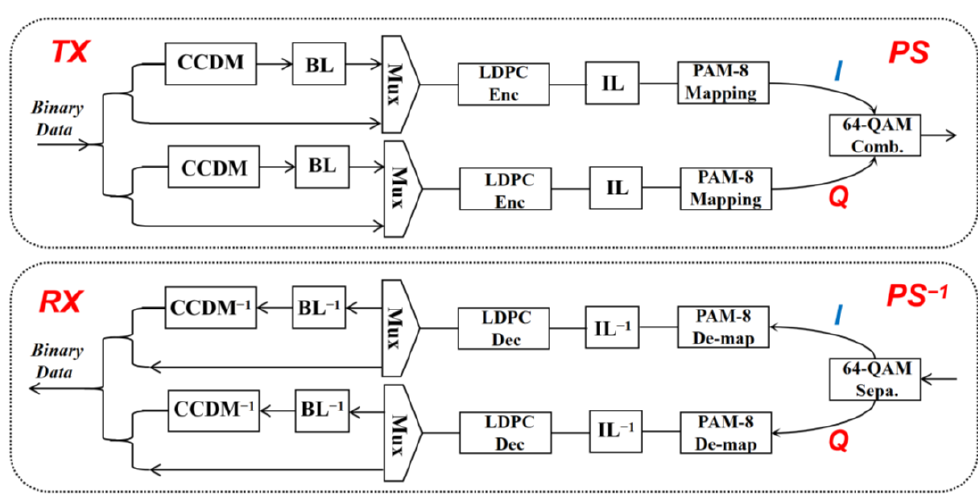
Figure 1. Schematic diagram of the PS-enabled DMT system.